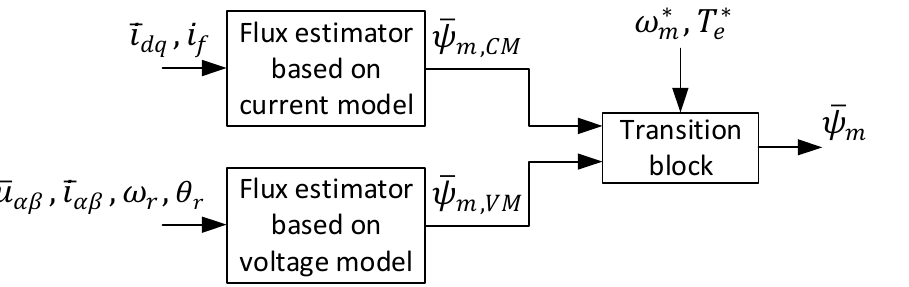
Figure 2. Block diagram of the proposed flux estimator for salient pole synchronous machine.